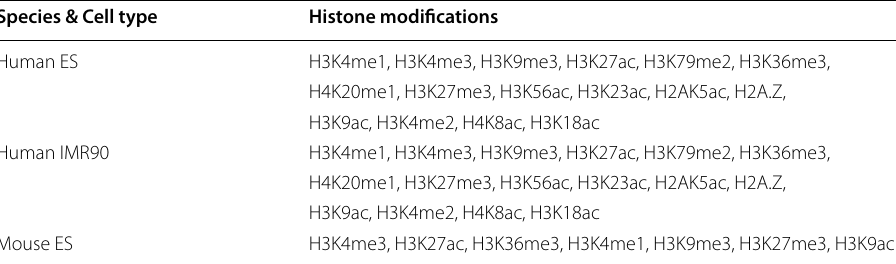
Table 1 Histone modifications used in our experiments Species & Cell